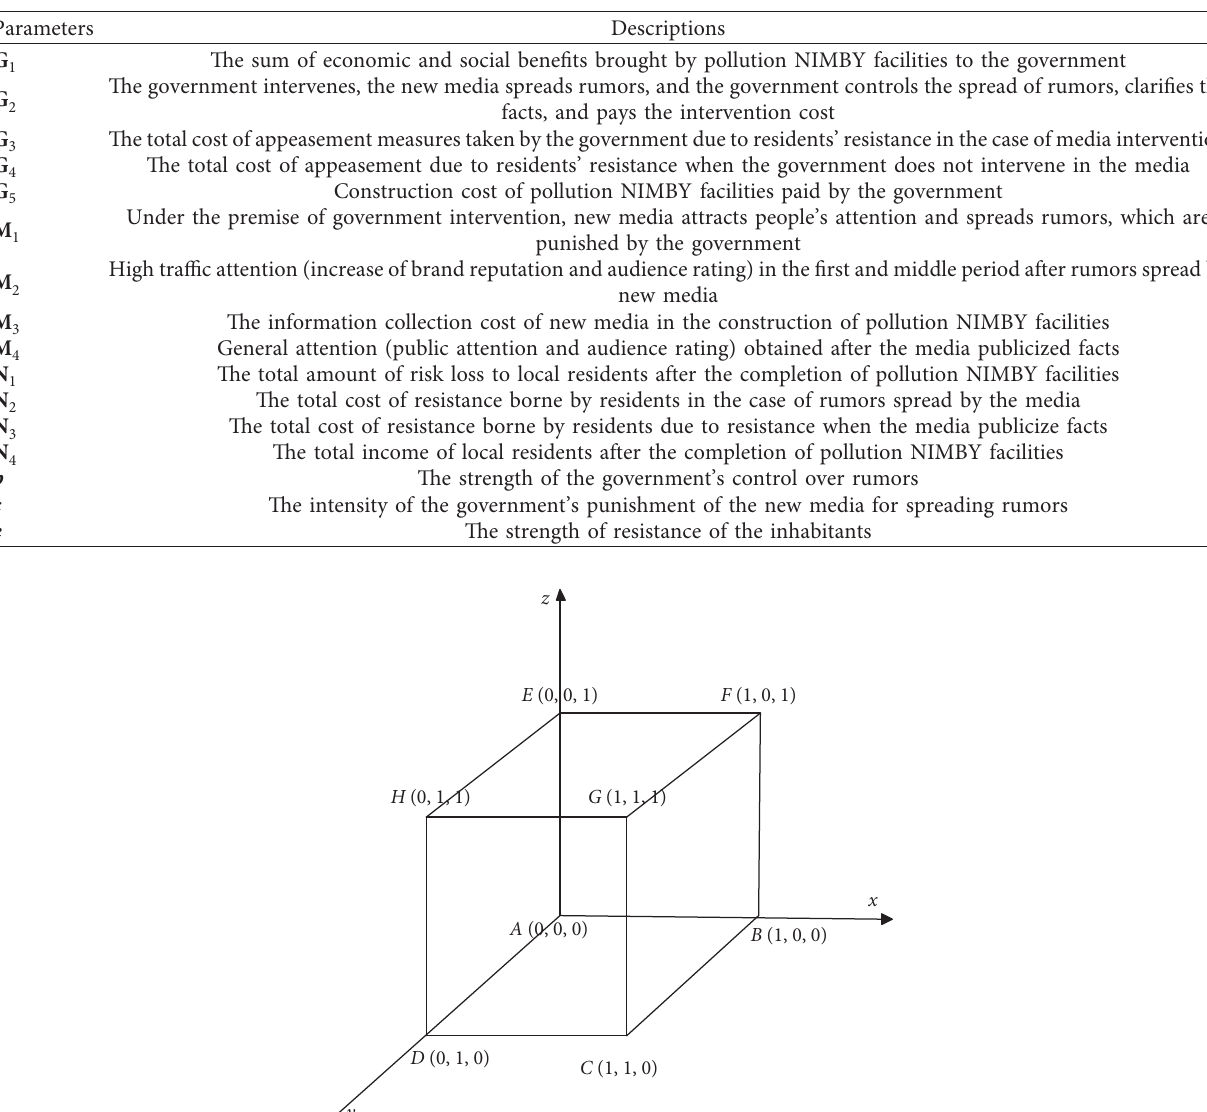
Table 1: Parameters and descriptions.